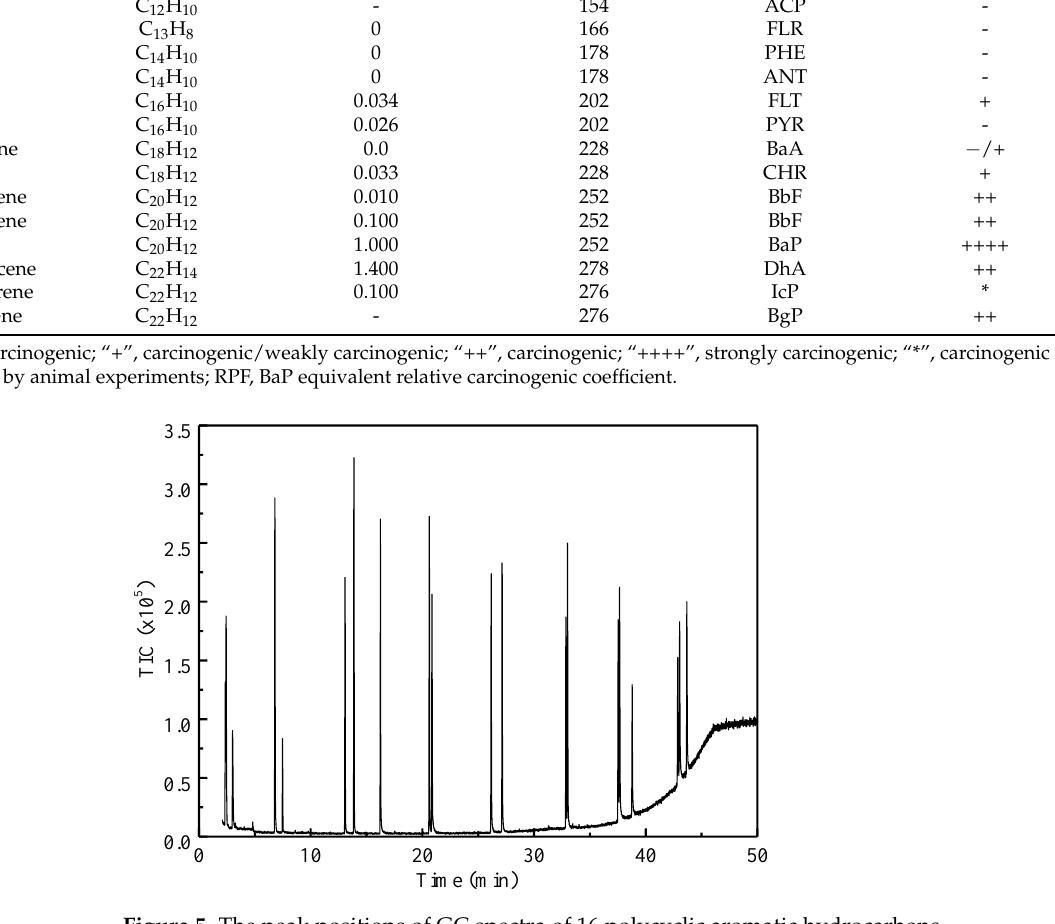
Figure 5. The peak positions of GC spectra of 16 polycyclic aromatic hydrocarbons. Table 5. Property of 16 PAHs proposed by EPA. Table 6. Standard curves of 16 PAHs based on the external standard